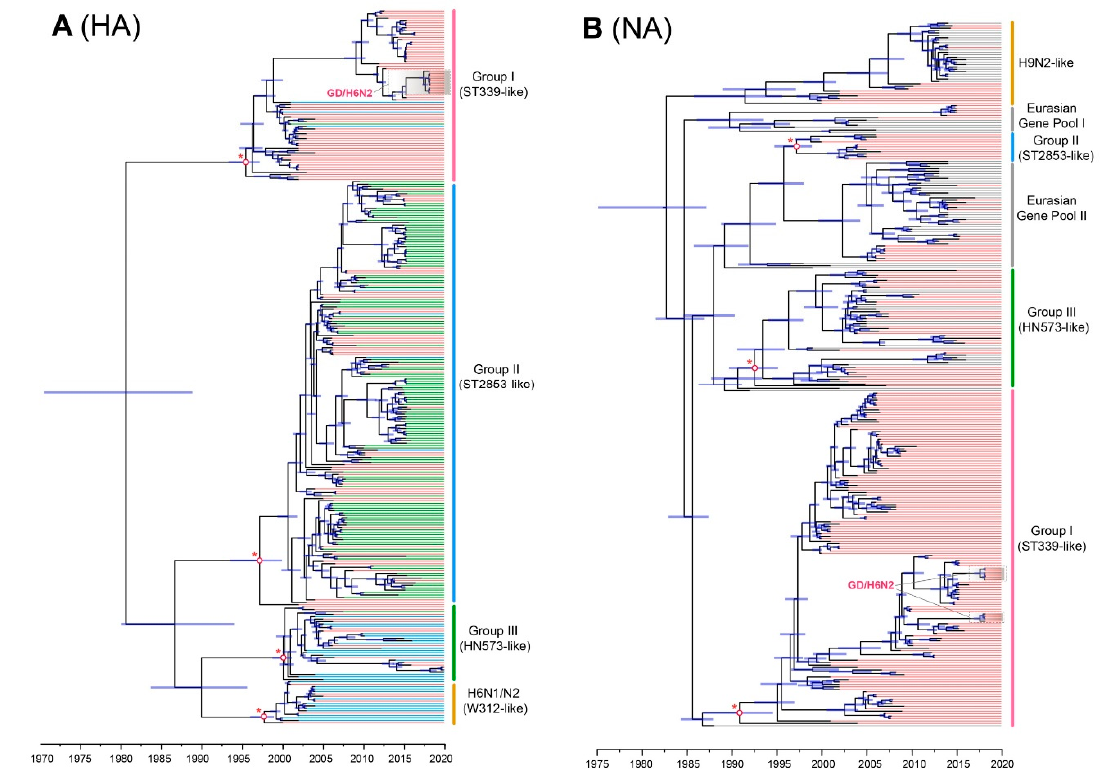
Figure 3. Time-scaled evolution of HA and NA genes of H6Nx viruses. ( A ) A maximum clade credibility tree of the HA sequence of H6Nx viruses sampled in China together with new H6N2 viruses is shown. H6Nx viruses containing N1, N2, and N6 subtypes are denoted by blue, red, and green colors, respectively. Shaded bars represent the 95% highest probability distribution for the age of each node. ( B ) A maximum clade credibility tree of the NA sequence of H6N2 viruses sampled in China together with new H6N2 viruses is shown. The phylogenetic tree was visualized in the FigTree (version 1.4.3) program. The H6N2 and the H9N2 subtypes are denoted by red and grey, respectively. Abbreviations: ST339, A/duck/Shantou/339/2000 (H6N2); ST2853, A/wild duck/Shantou/2853/2003 (H6N2); HN573, A/duck/Hunan/573/2002 (H6N2).